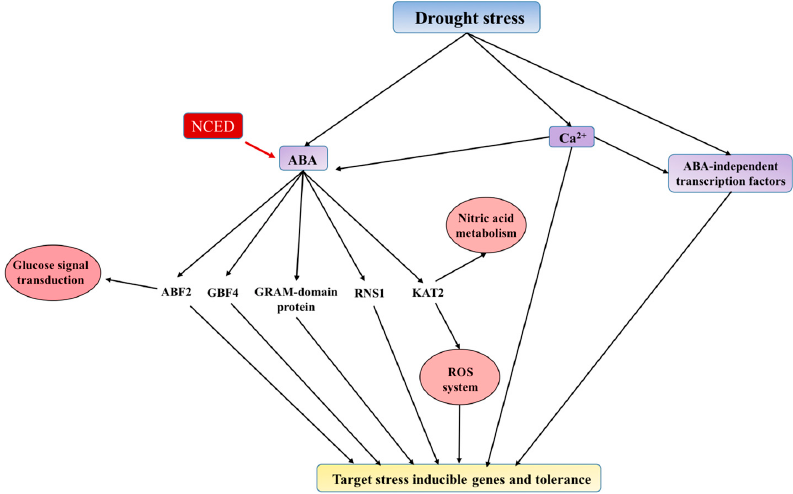
Figure 2. Schematic of the drought-induced signaling pathway based on proteome changes in switchgrass leaves. The biosynthesis of abscisic acid (ABA) was increased due to the elevated level of 9- cis -epoxycarotenoid dioxygenases (NCED) protein in drought-treated leaves. The elevated ABA level concurs with the induction of several ABA-responsive transcription factors, such as ABF2 (ABA-responsive elements-binding factor 2), GBF4 (G-box binding factor 4), GRAM, and ABA-responsive proteins including RNS (secreted ribonuclease) and KAT2 (3-ketoacyl-CoA thiolase-2). The ABA-independent signal transduction pathway appears to also play a role in drought-induced molecular regulation in switchgrass leaves. Several signal transduction processes may involve a second messenger (Ca 2+ ).